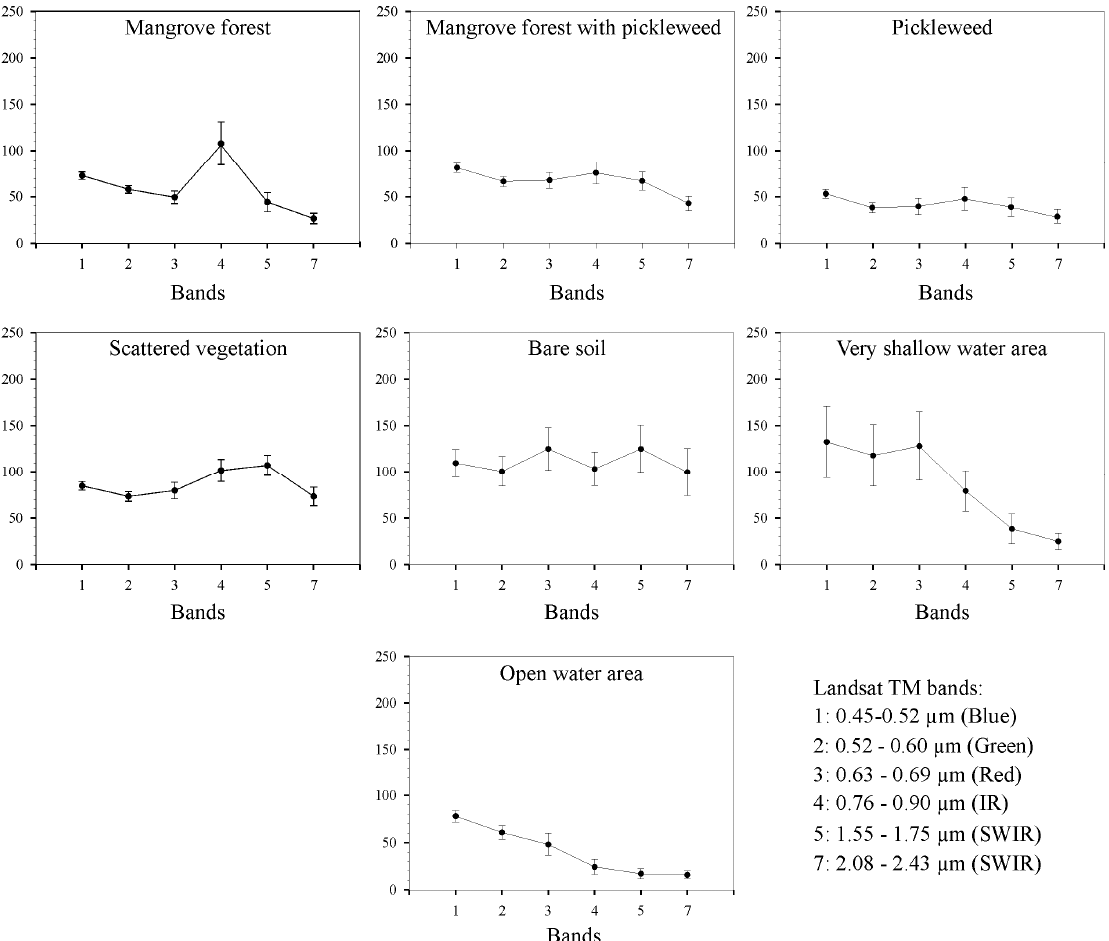
Figure 3. Spectral signature of each thematic class. Vertical bars indicate standard deviations of average reflectivity.